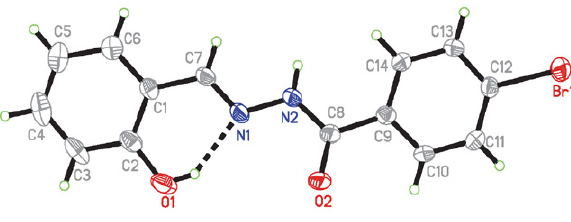
Figure 1. ORTEP plots (30% probability level) and numbering scheme for H 2